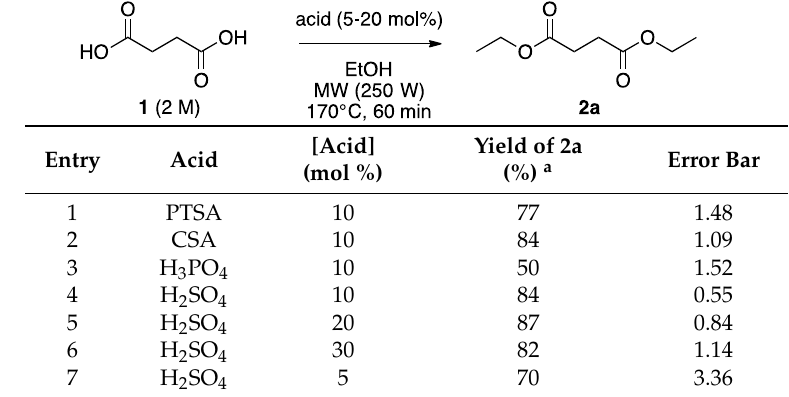
Table 2. Batch microwave-assisted diethyl succinate ( 2a ) synthesis by varying the nature and the amount of acid at 250 W.